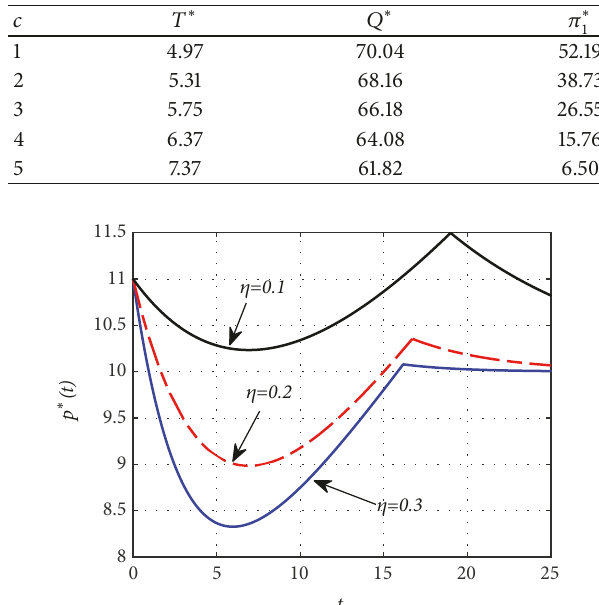
Table 4: The impact of c on decisions of retailer.